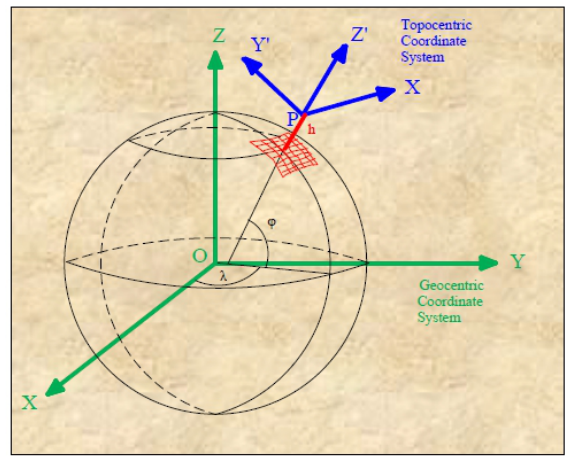
Figure 3. Relation between Earth fixed ( X,Y,Z ) and local ( X ′ ,Y ′ ,Z ′ ) Cartesian